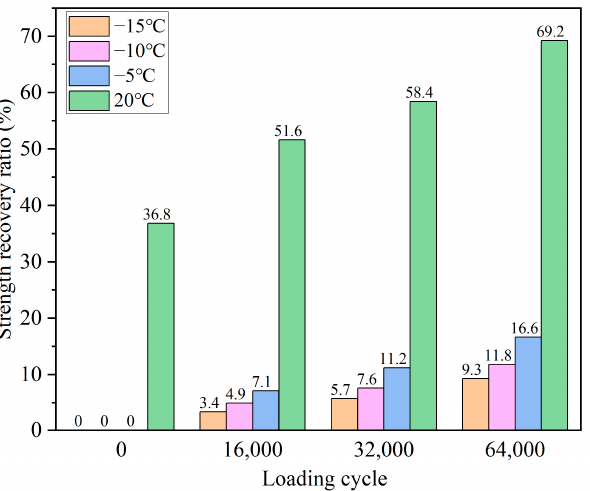
Figure 11. Healing ratio of capsule asphalt concrete beams after compression loading at different service temperatures.